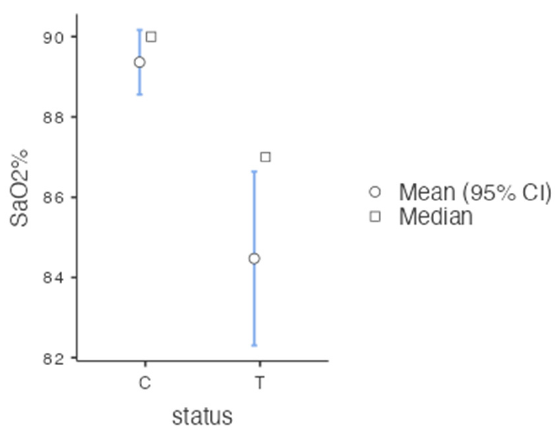
Figure 5. Axial CT slice of 0.6 mm thickness for teeth 807 (14 days after Biodentine TM DPC) and 707 (control) with pulp density measurements (expressed in HU), red arrow: conducted at the same level for both teeth (CT: 663 HU in tooth 807 and CT:817 HU in tooth 707). Table 2. Average values of pulp density (HU) measured on CT scans in all treated and control groups.